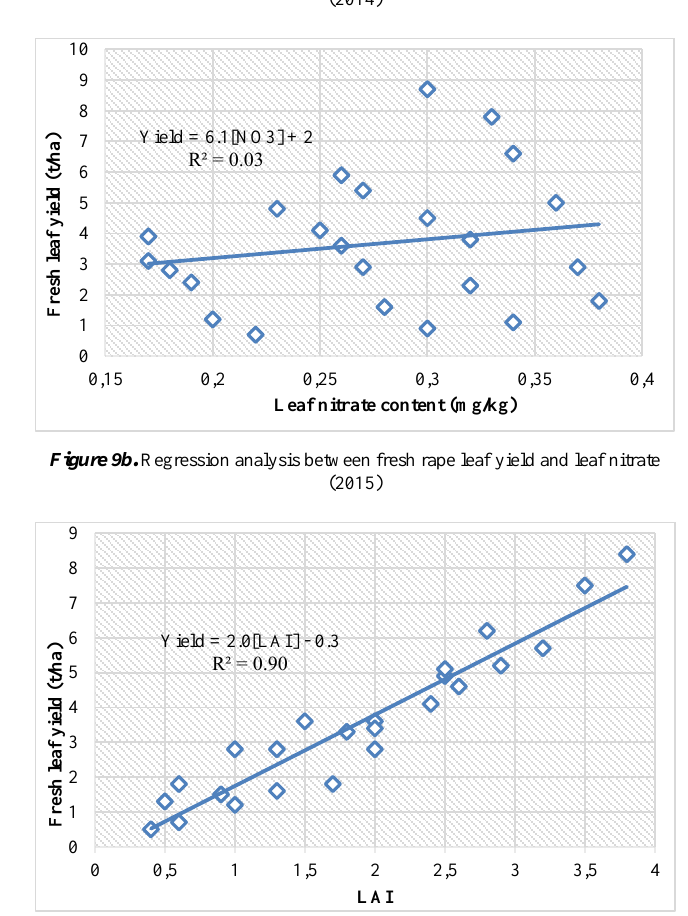
Figure 9a. Regression analysis between fresh rape leaf yield and leaf nitrate (2014)